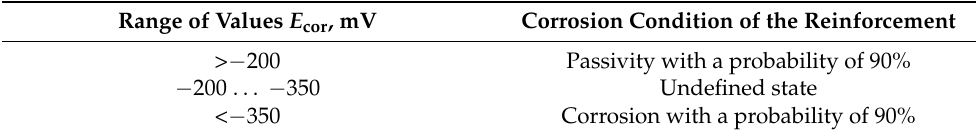
Table 1. Range of HCPs of steel reinforcements in concrete used for the assessment of the corrosion condition (with regard to the copper/copper sulphate reference electrode at 20 ◦